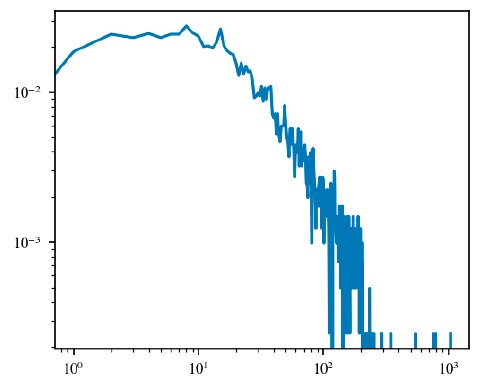
Figure 2. Degree distribution in the Facebook network.